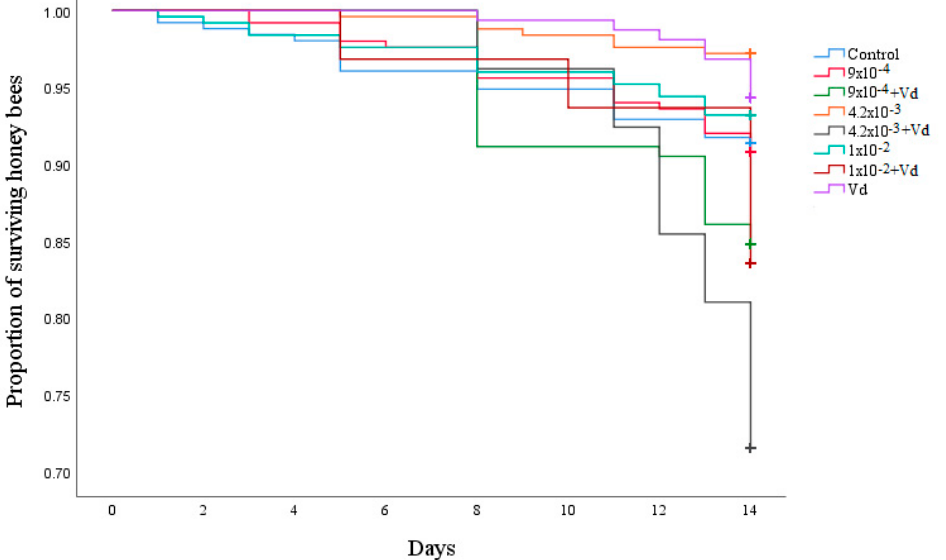
Figure 1. Kaplan–Meier survival curves of adult bees exposed to field realistic doses of clothianidin (0 ng clothianidin/µL, 9 × 10 − 4 ng clothianidin/µL, 4.2 × 10 − 3 ng clothianidin/µL, and 1 × 10 − 2 ng clothianidin/µL) and/or V. destructor (Vd) for 14 consecutive days. There was no significant e ff ect of the treatments on sucrose syrup consumption (H (7) = 9.75, p = 0.20; Table